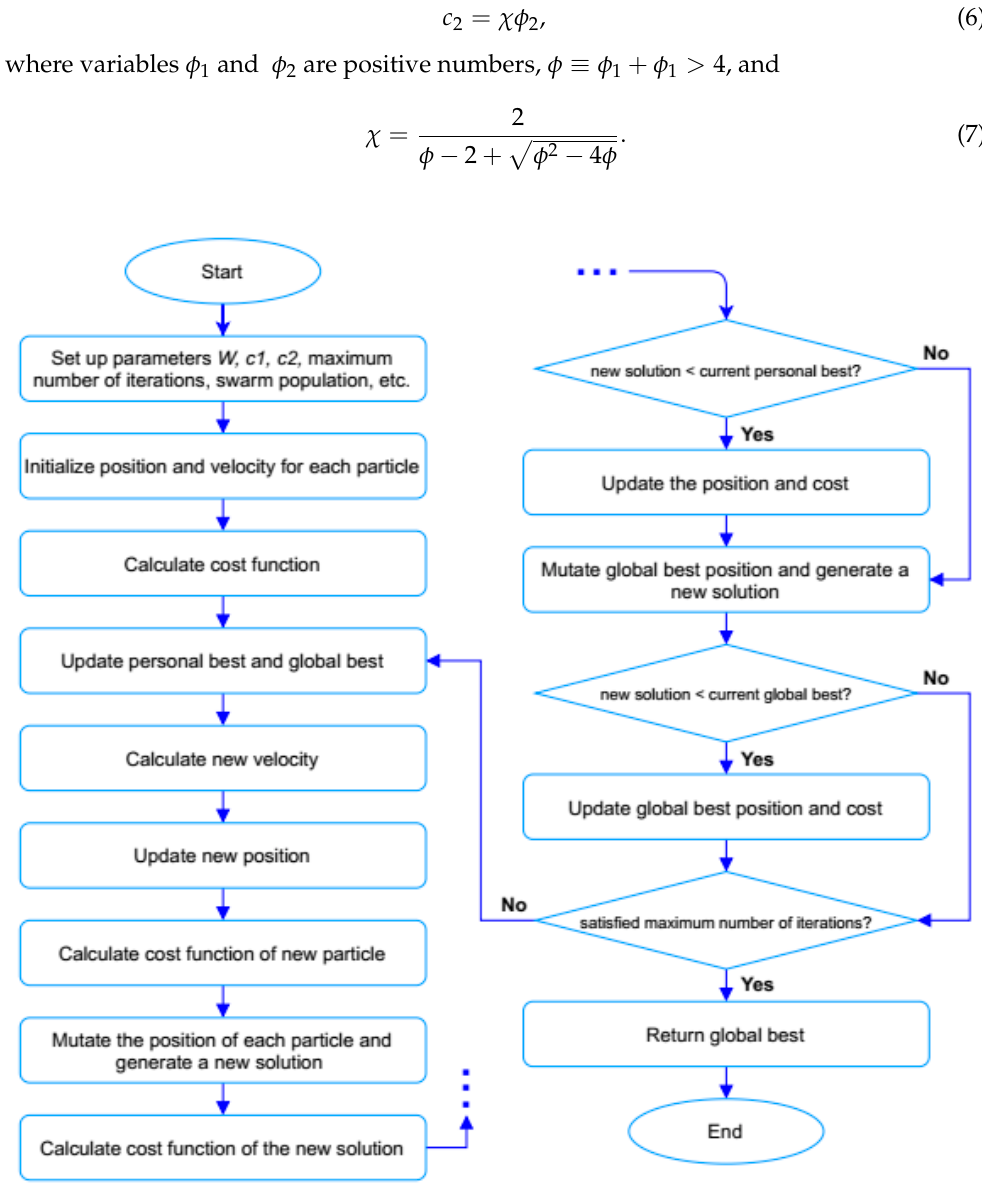
Figure 7. Flowchart of enhanced particle swarm optimization algorithm. According to [68], the optimal values for the above parameters are φ 1 = φ 1 = 2.05, w = 0.7298, and c 1 = c 2 =